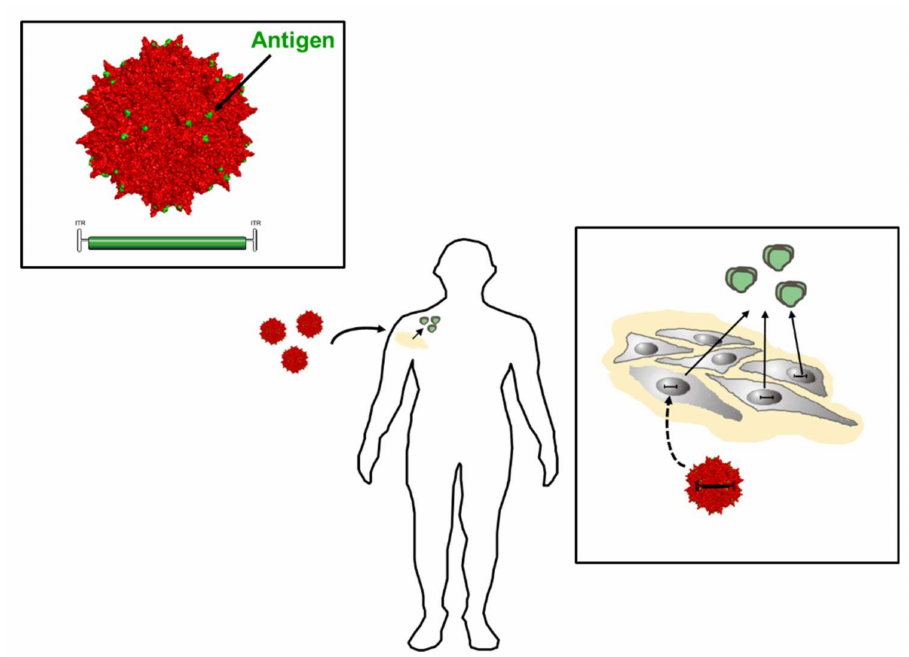
Figure 9. Adeno-associated viruses (AAV) vector-based vaccine approaches. Vectors deliver vector genomes that encode for antigens such as Env for continuous secretion from vector-transduced muscle cells. The choice of promoter defines the strength of antigen expression as well as the cell type that produces respective antigens. Capsid engineering technologies have allowed development of the next generation of vector-based vaccines, in which vector capsids (red) serve as scaffolds for antigen display (green dots). Thereby, a patient’s immune system is primed upon vector delivery through antigens already displayed on the capsid that at the same time functions as an innate immune stimulant. Following muscle transduction with these “prime-boost” vectors, the vector-encoded protein antigen is then secreted, providing the source for the antigenic boost (green Env trimers,